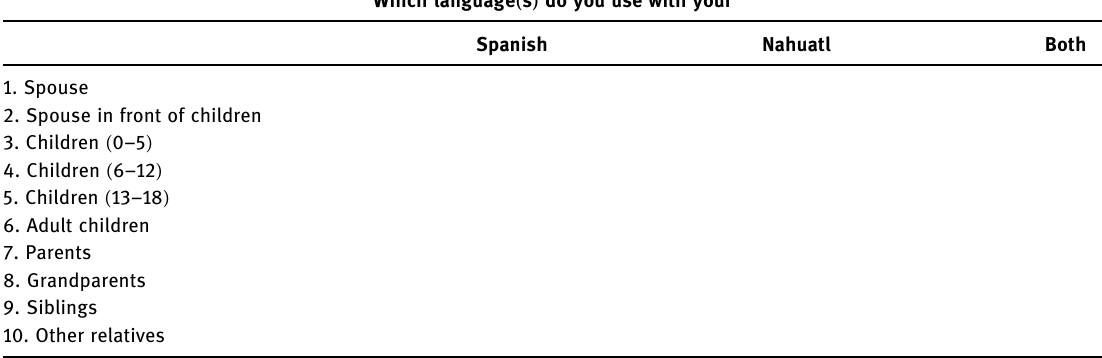
Table 3: Linguistic questionnaire